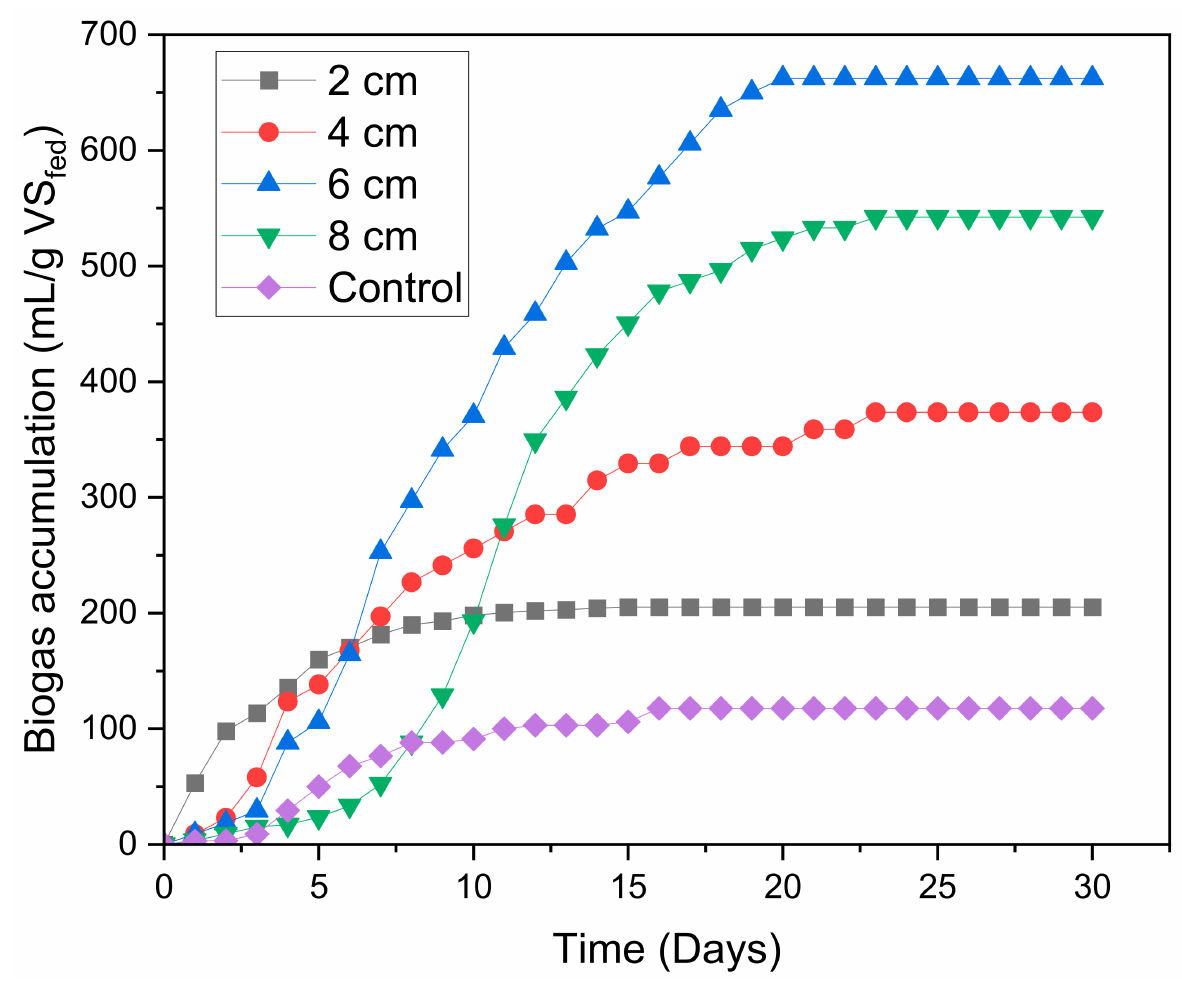
Figure 1. Biogas accumulation as a function of